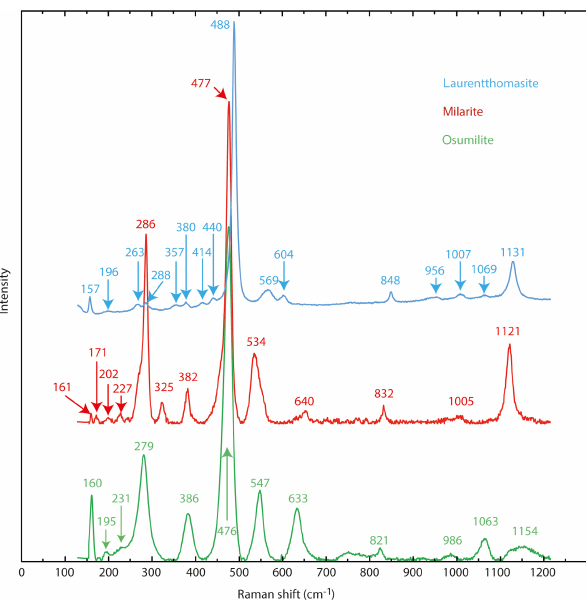
Figure 4. Raman spectrum of laurentthomasite compared to those of milarite and